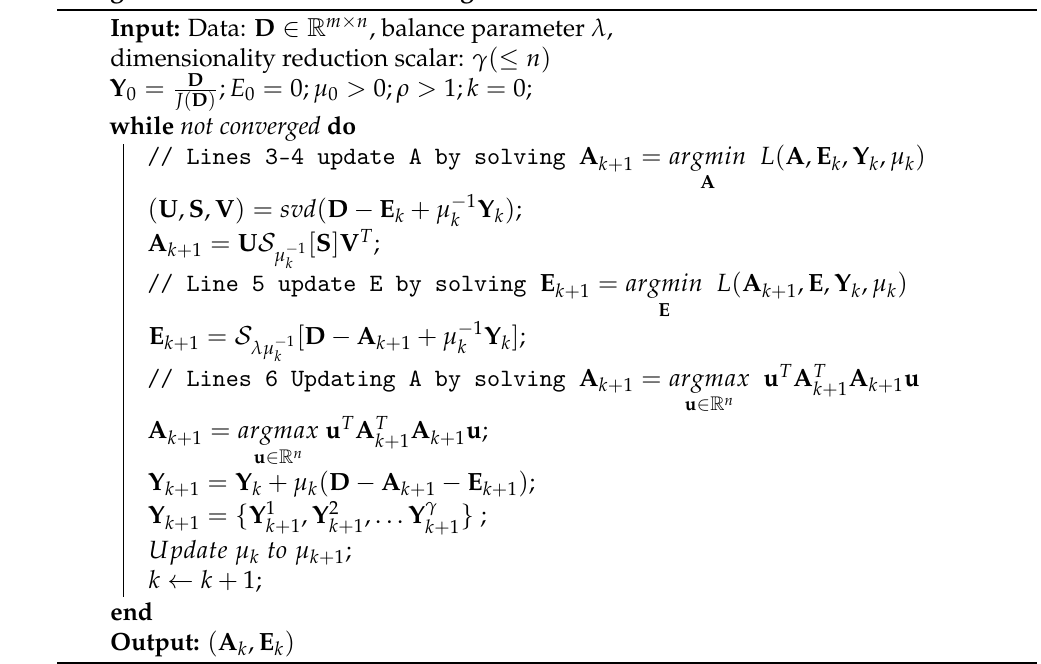
Algorithm 1: RPCA via the Orthogonal IALM